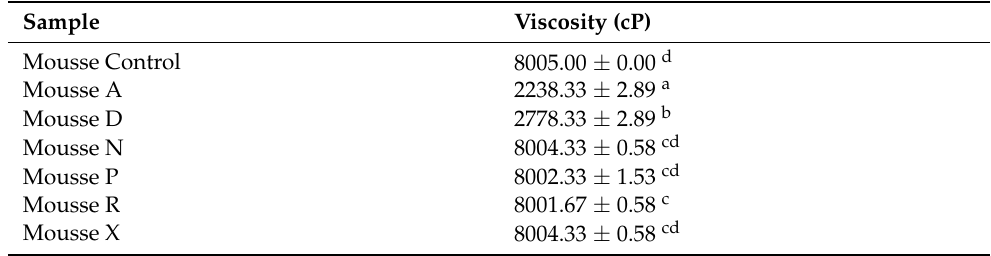
Table 8. Viscosity of chocolate mousses.